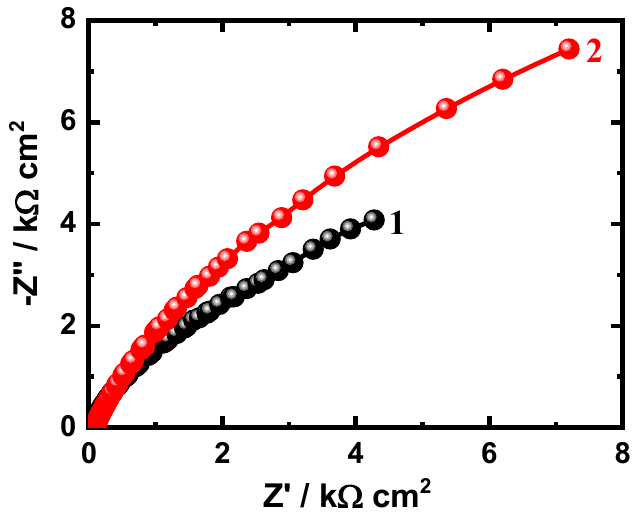
Figure 4. Nyquist plots for (1) Ti and (2) Ti85-Zr15 after 1.0 h exposure to SBF. Values of R S , R P1 , and R P2 are higher for Ti-Zr alloy than those values listed in Table 2 for pure Ti only. The total corrosion resistance (R P ) equals the sum of R P1 , and R P2 , i.e., R P = R P1 + R P2 . Furthermore, the presence of Q showed that the formed films have a complex structure, indicating that two layers are probably formed. A high-frequency inner layer is characterized by dominant impedance, while a low-frequency outer layer is porous and characterized by dominant impedance [24–29]. The Q 1 and Q 2 , with the values of their “n”, are assigned the role of a double-layer capacitor, C dl , which confirms the existence of pores on the outer layer. Those C dls signify that Zr increases the passivity of the Ti in